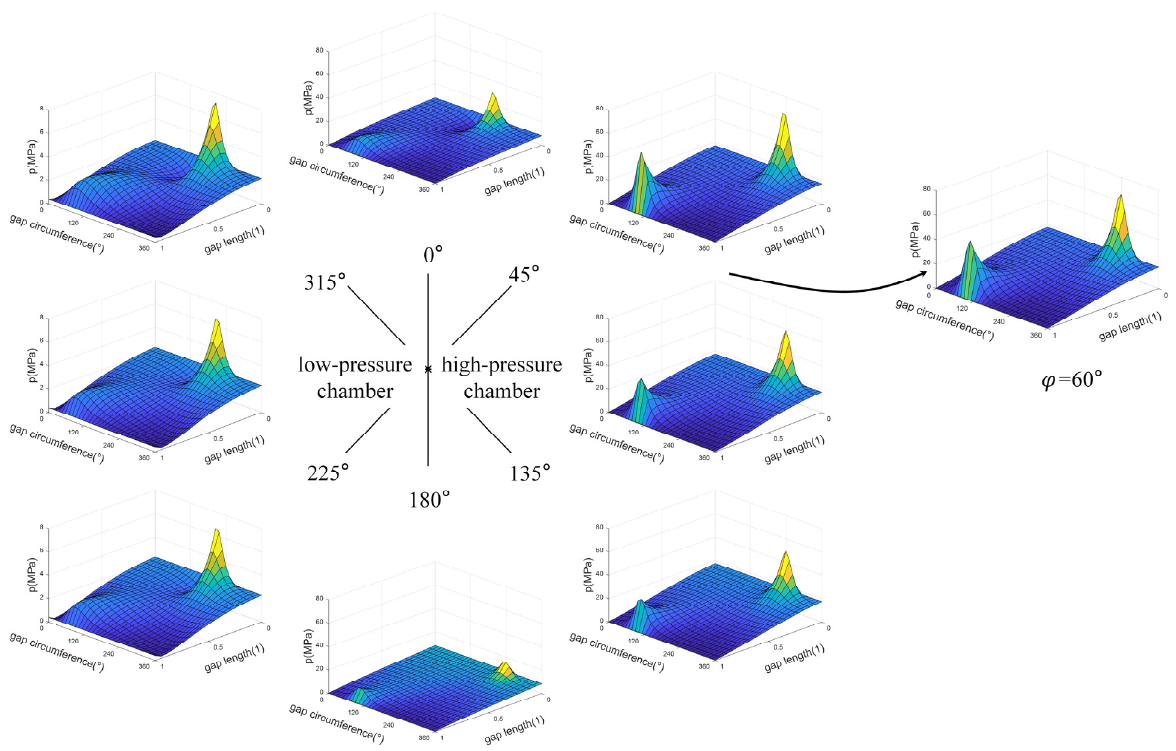
Figure 12. The distribution of the film pressure.